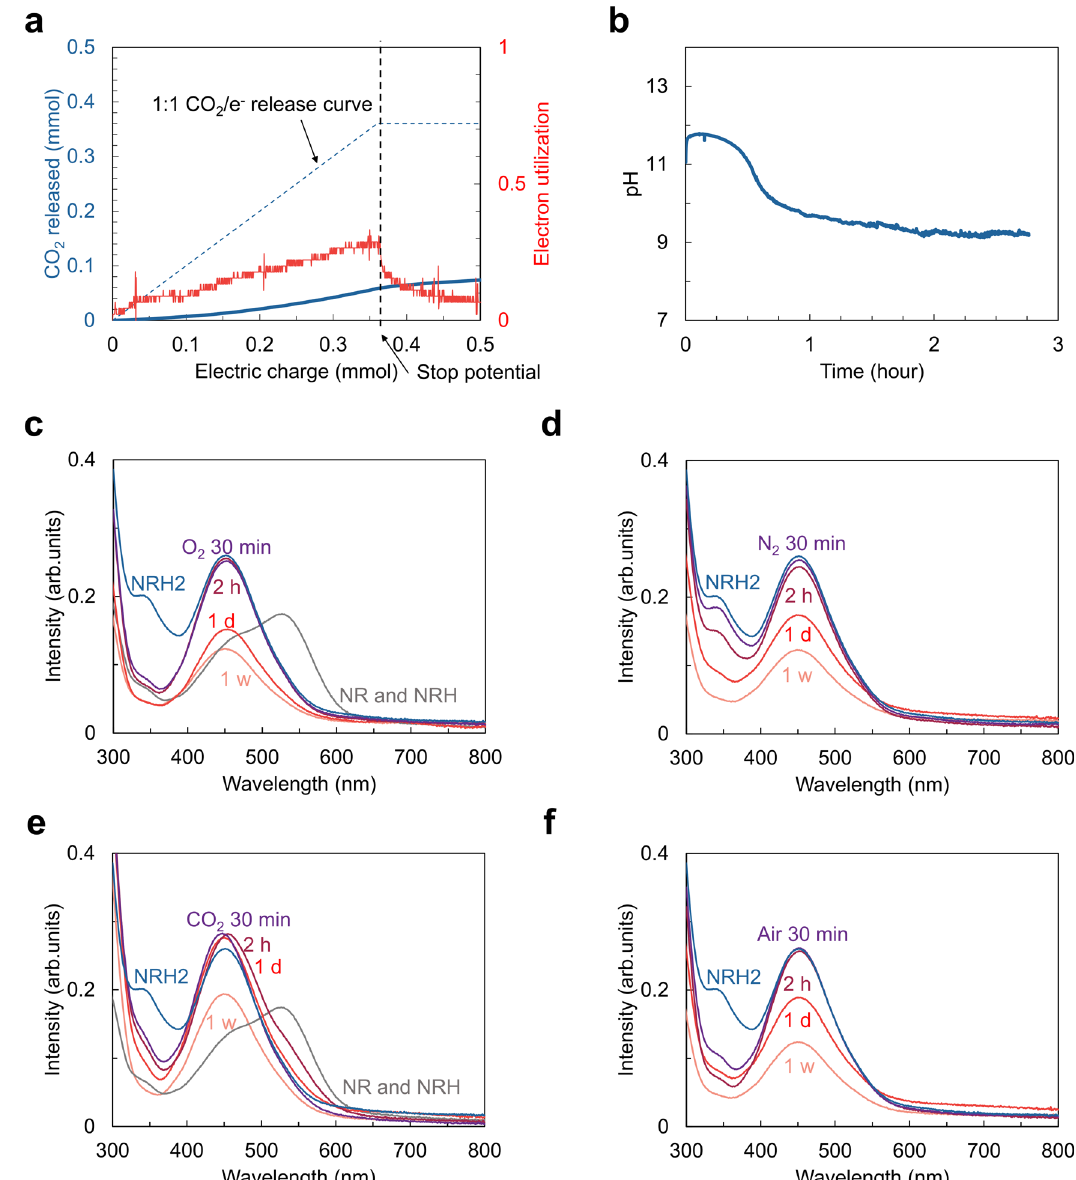
Fig.5|DirectaircaptureandstabilitytestofNRH2solutions.a CO 2 releasedby electrochemicaloxidation on the application of a constant current of 50mAto the NRH2 solution (50mM, 4mL) bubbled with air for 3h at a fl ow rate of ca. 120mL/ min. The amount of released CO 2 (blue curve) and electron utilization (red curve) areshownversuselectriccharge. b InsitupHmeasurementversustimefor5mLof 50mM NRH2 solution bubbled with ambient air. c UV – vis spectra for the oxygen sensitivity test. The NRH2 solutions (blue curve, 50mM, 1mL) were bubbled with pure oxygen for 30min (purple), 2h (dark red), and 1 day (red) at a fl ow rate of 3mL/min and sealed under oxygen for 1 week (pastel red). Gray curve represents UV – vis spectraof NR and NRH. d UV – vis spectrafor the control experiment under